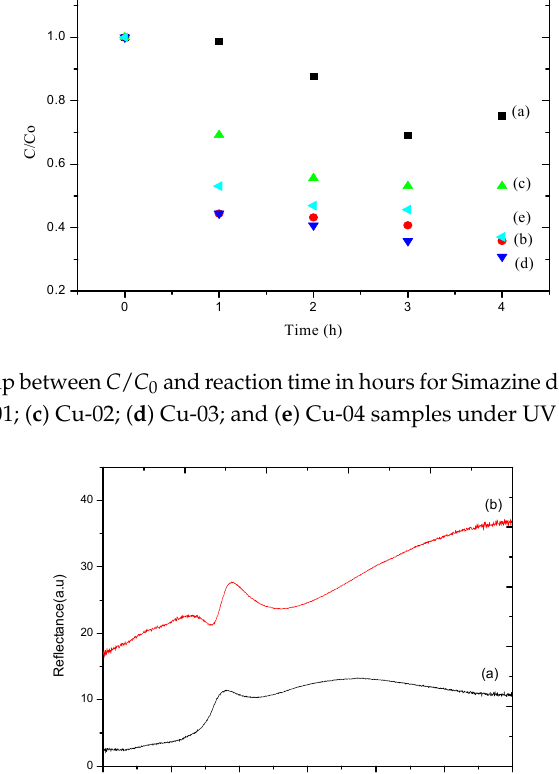
Catalysts 2016 , 6 , 167 12 of 16